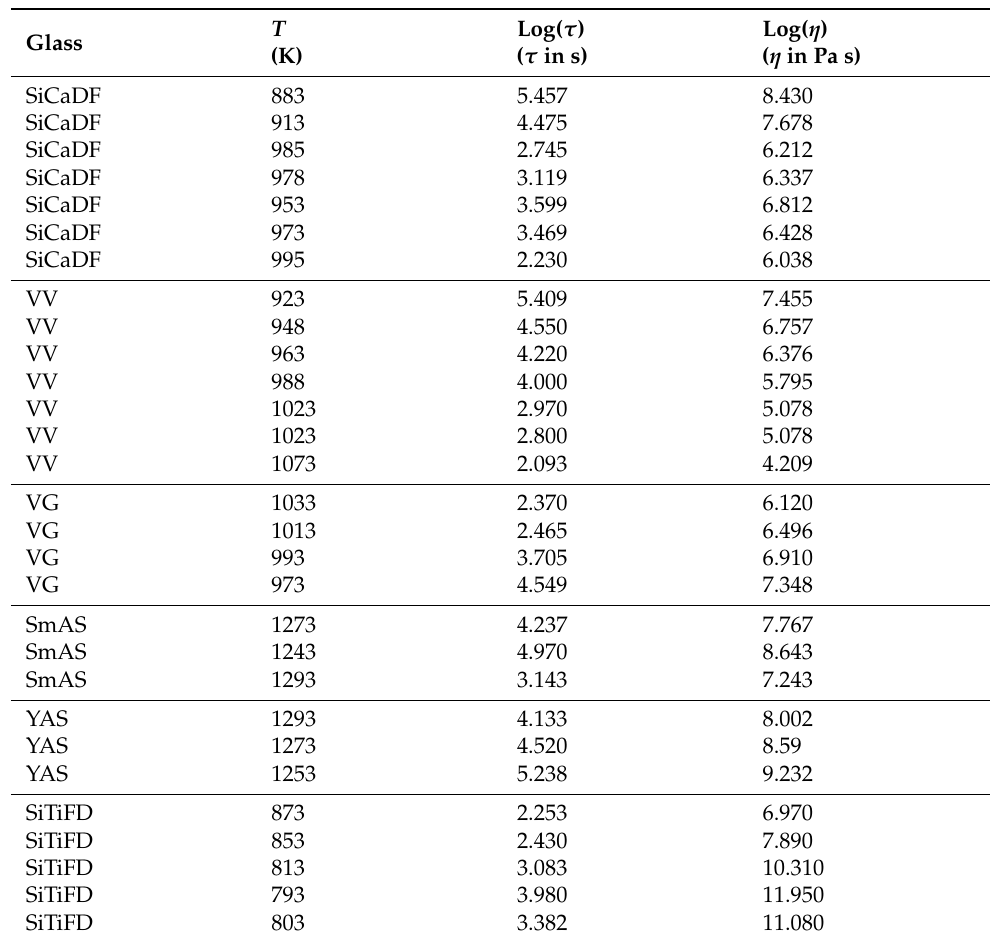
Table 3. T, log( τ ) measured using high temperature microscopy, and log( η ) calculated using VFT functions shown in Table 2. T , τ , η values to build the masterfunction η = η ( T , τ